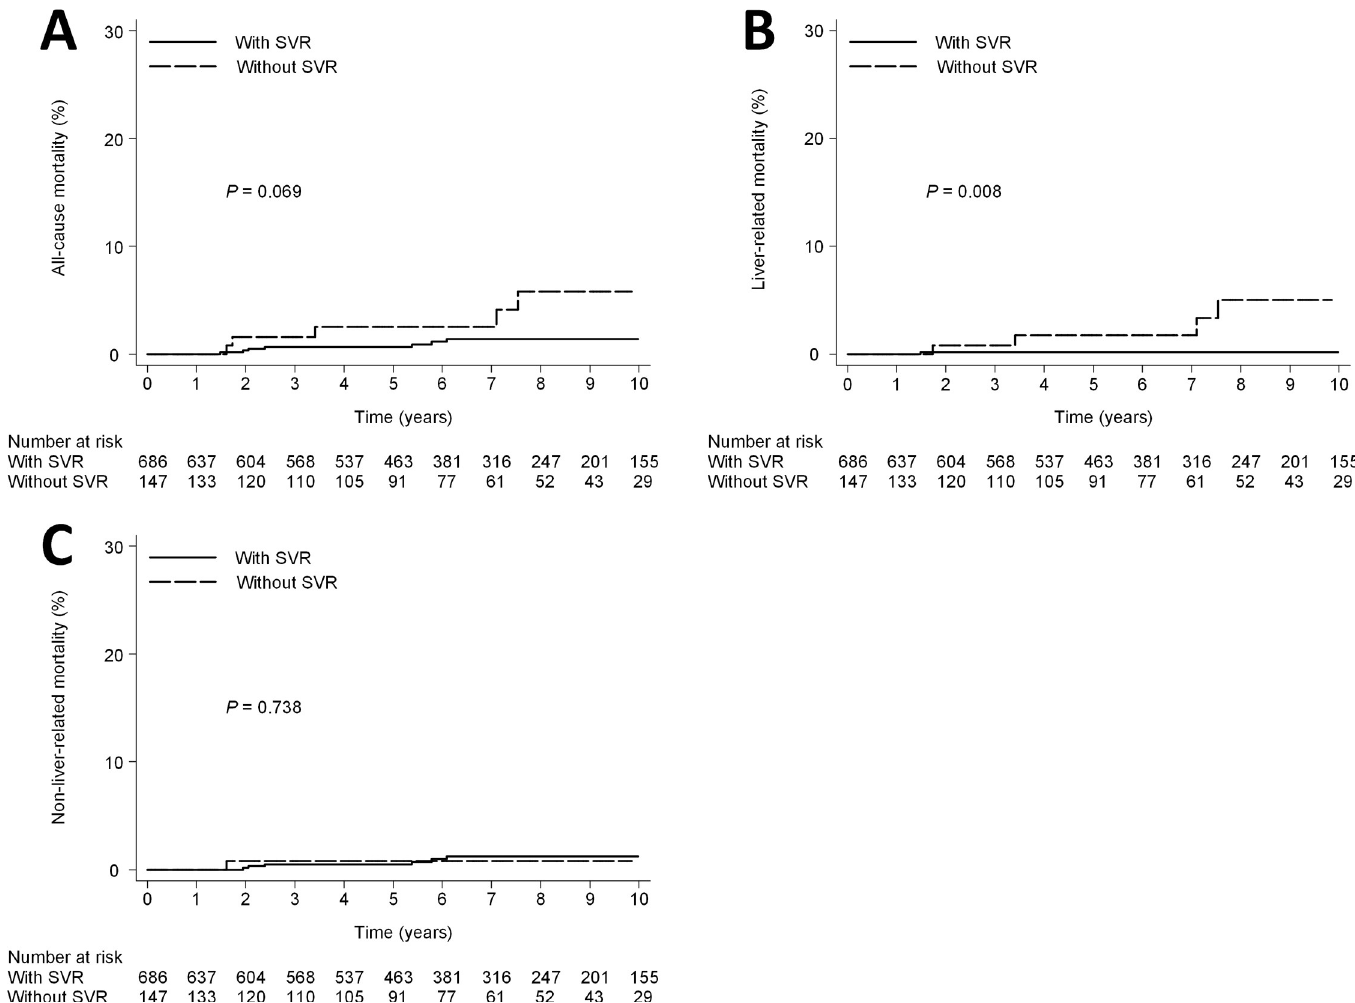
Fig 4. Mortality according to SVR in mild fibrotic patients. (A) all-cause mortality (10- year mortality rate, 1.5% vs 5.8%; HR, 0.36; 95% CI, 0.12–1.1; P = 0.07). (B) liver- related mortality (10- year mortality rate, 0.2% vs 5.0%; HR, 0.01; 95% CI, 0.02–0.54; P = 0.008). (C) non-liver-related mortality (10- year mortality rate, 1.3% vs 0.8%; HR, 1.4; 95% CI, 0.18–11.11; P =